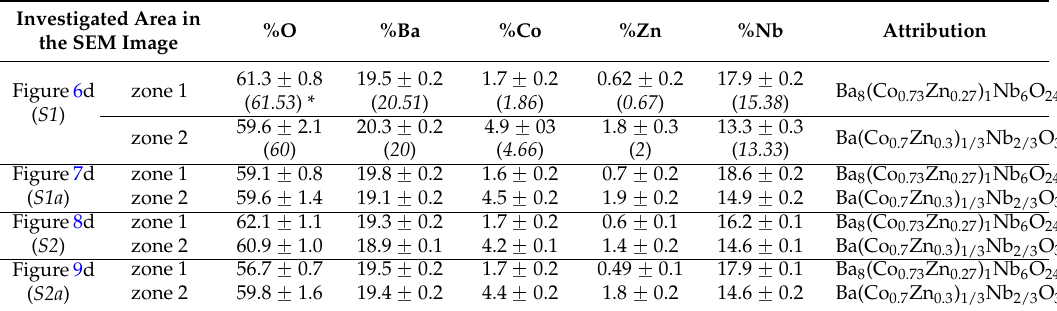
Table 1. Atomic percentages obtained from EDS analyses on areas of interest by moving the analyzing spot. Zones 1 and 2 correspond to light grey and dark grey areas, respectively, mentioned in Figures 6d, 7d, 8d and